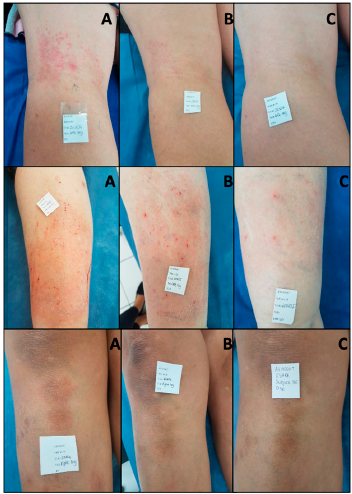
Figure 3. Pictures taken of present lesion of subject # 6 (Top row) # 24 (middle row) and # 36 (bottom row) in the probiotic product group from baseline ( A ), visit 2 ( B ), and end of study visit ( C ). Pictures were taken by the dermatologist investigator at the study clinic.